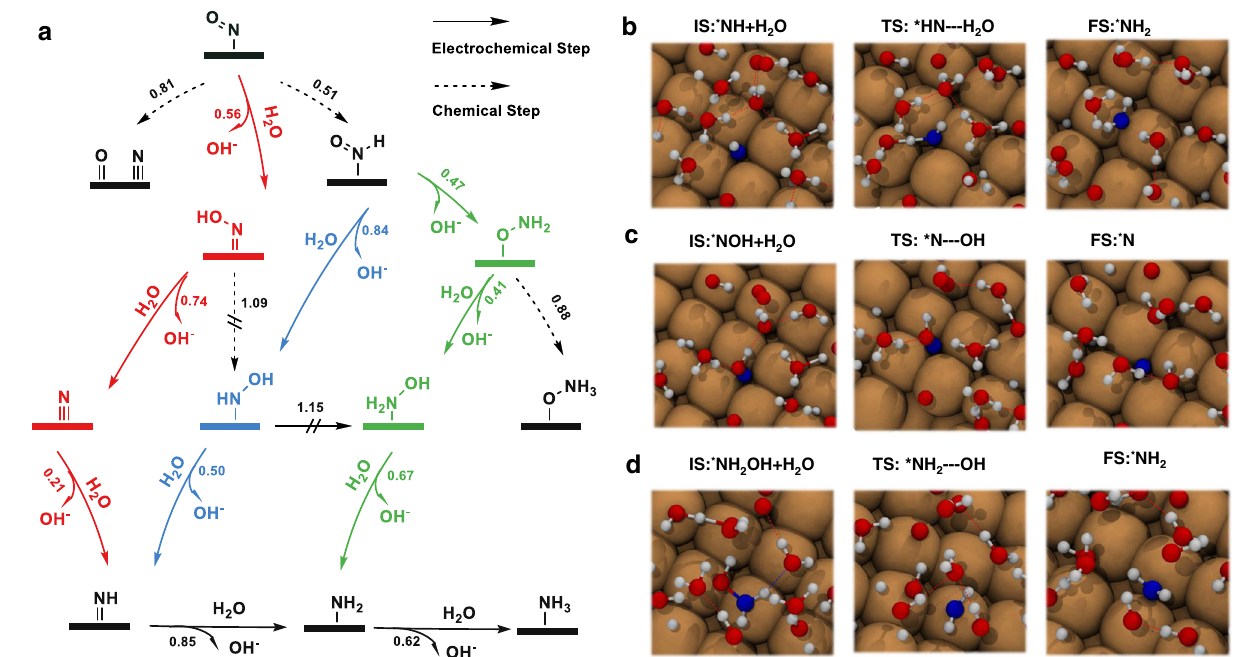
Fig.2|Reactionpathwaysandsnapshotsfor*NOreductiontoNH3.a Schematic diagram of kinetically preferred reaction pathway from * NO to ammonia (NH 3 ) at ~ − 0.75V vs SHE.Both chemical and electrochemicalsteps areconsidered.Chemical reaction steps are indicated by dashed lines, whereas electrochemical steps are indicated by solid lines. Steps with a barrier higher than 1.0eV are marked with a doubled bar line (||) and considered as precluded (blocked) steps at 300K. All kinetic barrier values are reported in eV. Three different pathways are marked in